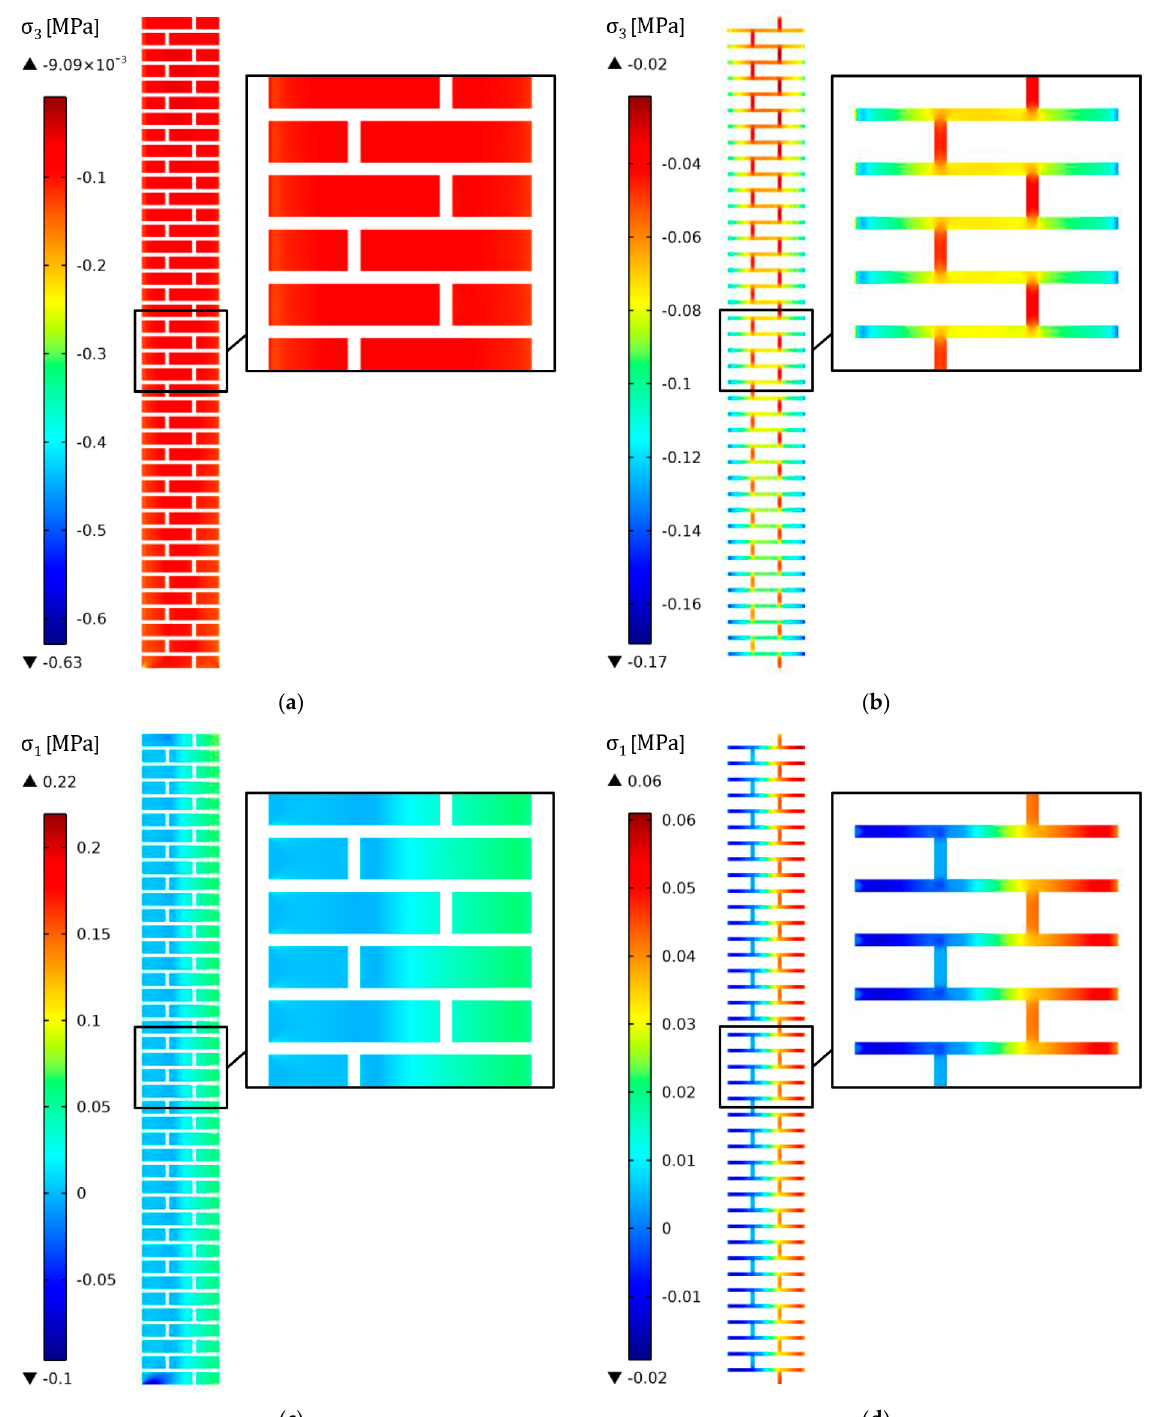
Figure 14. Hygro-thermo-mechanical analysis of the three-wythe brick masonry wall with natural hydraulic lime mortar. Principal stress distribution obtained for the hygro-thermo-mechanical case: minimum principal stress, 𝜎 (cid:2871) [MPa], in ( a ) bricks and ( b ) mortar joints; maximum principal stress, 𝜎 (cid:2869) [MPa], in ( c ) bricks and ( d ) mortar joints.